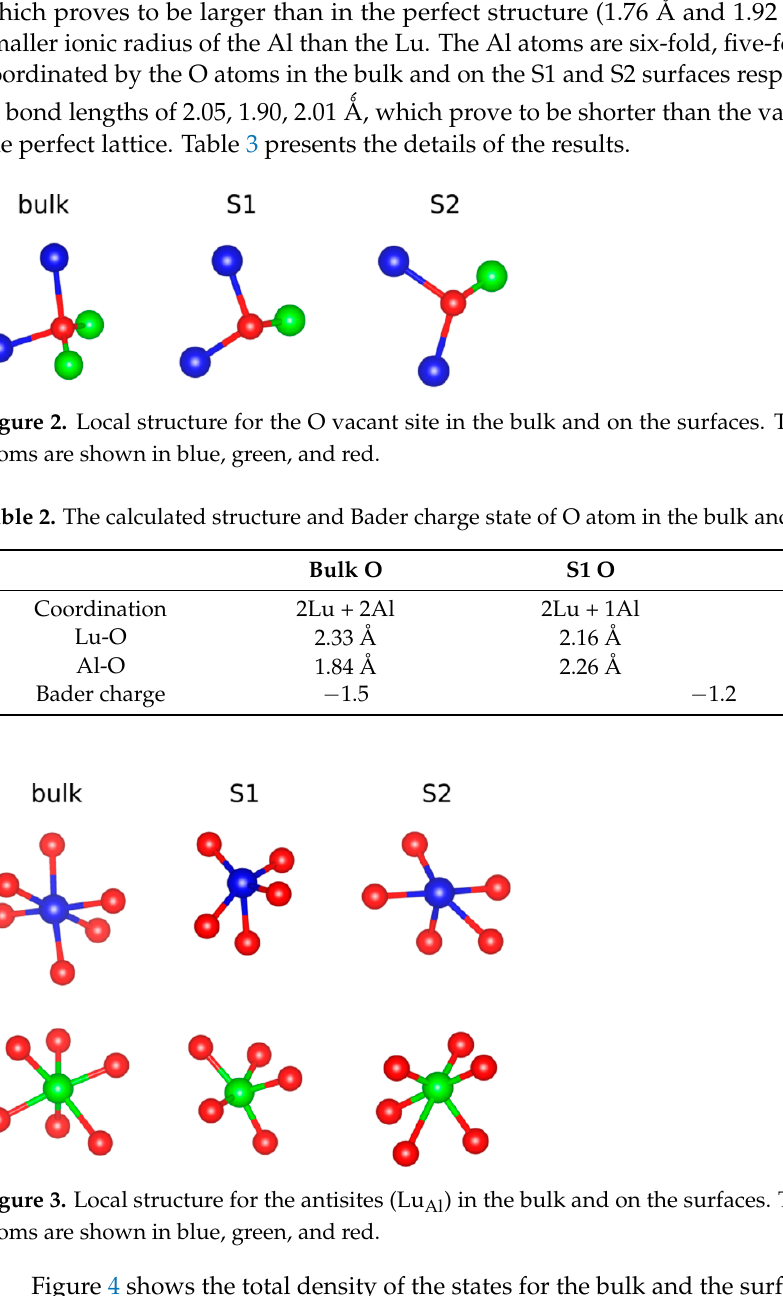
Figure 3. Local structure for the antisites (Lu Al ) in the bulk and on the surfaces. The Lu, Al, and O atoms are shown in blue, green, and red. Table 3. The calculated structure data of antisite defects Lu Al and Al atoms.